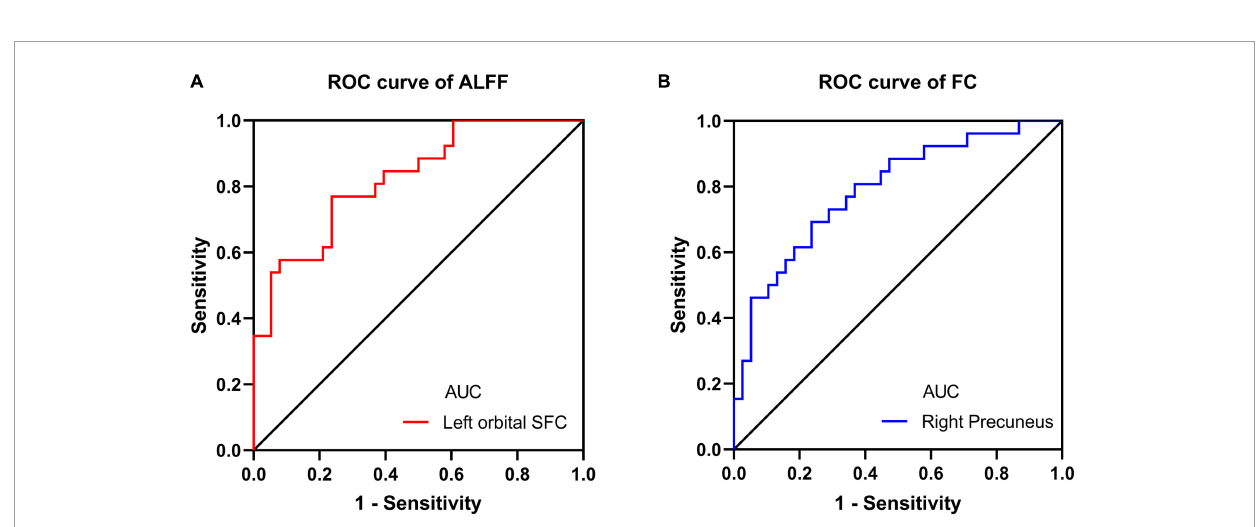
FIGURE4 ROC curve analysis for altered brain region. (A) The AUC of the ALFF values of the left orbital SFC was 0.8229 ( P < 0.001; 95% CI: 0.7211–0.9247); (B) the AUC of the FC values of the right precuneus was 0.7895 ( P < 0.001; 95% CI: 0.6762–0.9028). ROC, receiver operating characteristic; AUC, area under the curve; CI, confidence interval; SFC, superior frontal